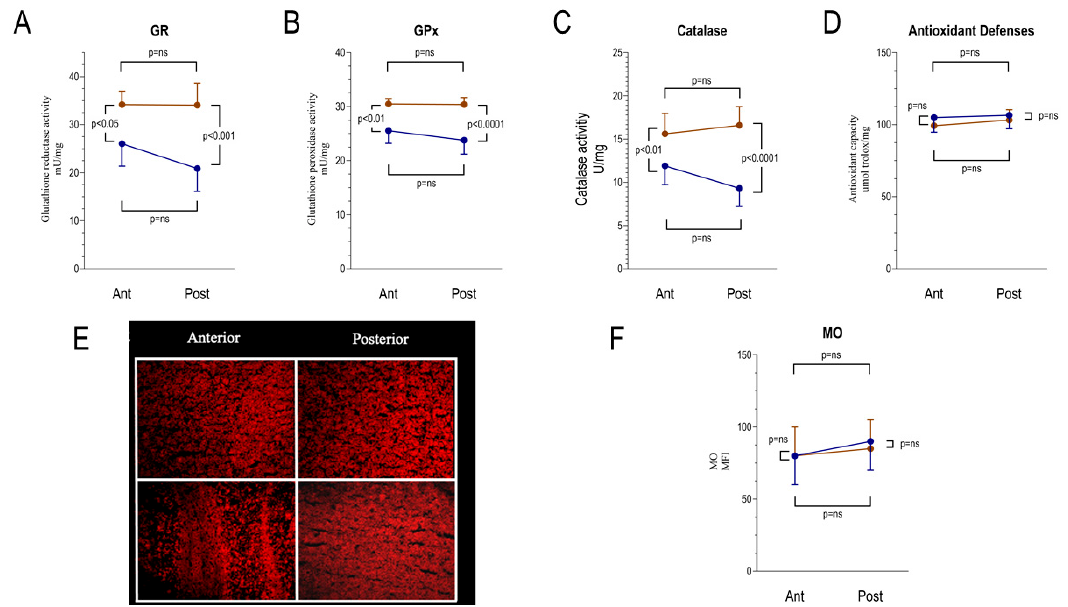
Figure 5. Antioxidant response to the hyperglycemia-related oxidative damage by anterior and posterior brain areas as assessed by spectrophotometry and cellular fluorescence. Panels A – C show the enzymatic activity of glutathione reductase (GR), glutathione peroxidase (GPx), and catalase (CAT) in the anterior (Ant) and posterior (Post) brain regions in control ( n = 6 for each area, blue) and STZ mice ( n = 6 for each area, brown). Panel D shows the total antioxidant capacity, evaluated as Trolox equivalent in the same subgroups. Panel E displays representative images of anterior and posterior brain areas stained with Mercury Orange (MO) and the corresponding mean fluorescence index (MFI, Panel F ) in the same subgroups. Data are expressed as mean ± SD.